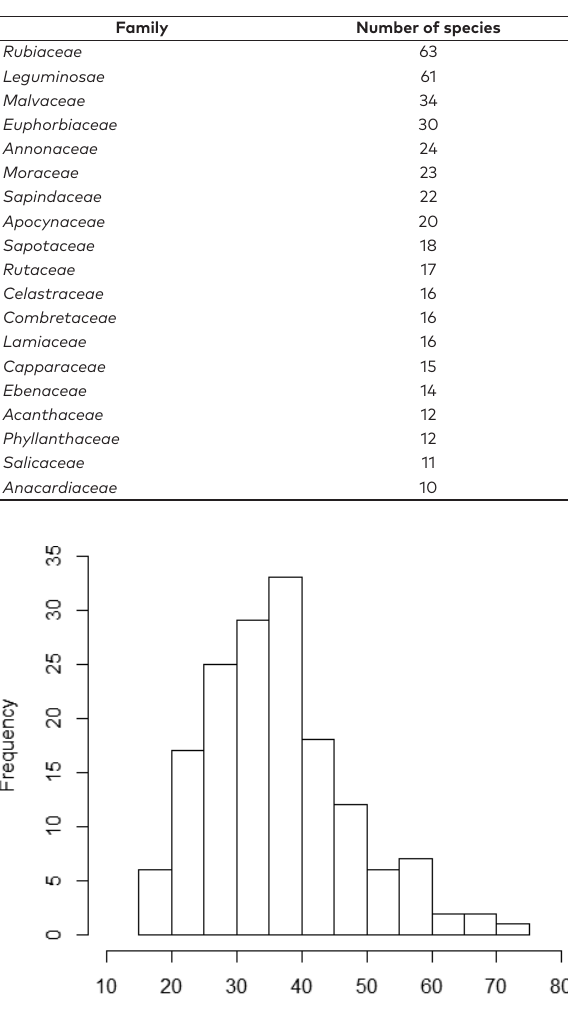
Table 2. List of the most diverse families in the Kenyan coastal forests vegetation-plot database, defined as those having at least 10 different recorded species.